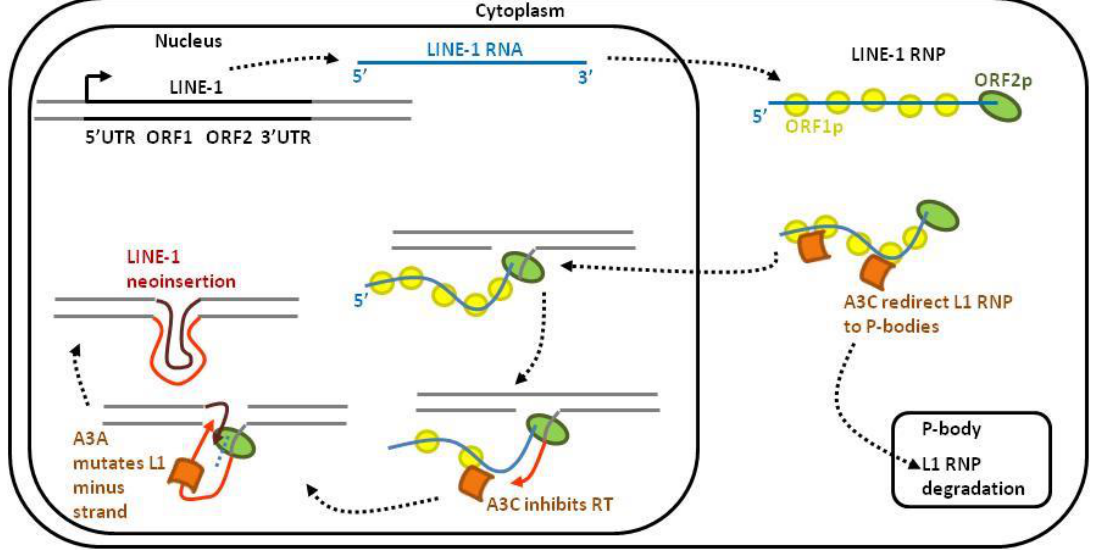
Figure 3. LINE-1 retrotransposons are targeted by APOBEC3s. After transcription, the LINE-1 mRNA is transported into the cytoplasm. After translation, the ORF1- and ORF2-encoded proteins associate with the LINE-1 RNA and form a ribonucleoprotein (RNP) complex. The LINE-1 RNP enters the nucleus, where the ORF2p endonuclease domain cleaves the chromosomal DNA. After cleavage, the 3′-hydroxyl is used by the LINE-1 reverse transcriptase to synthesize a cDNA of LINE-1. This target-site-primed reverse transcription typically results in the insertion of a 5′-truncated LINE-1 element into a new genomic location. Different APOBEC3s-dependent mechanisms control LINE-1 retrotransposition: (1) in the cytoplasm, A3C interacts with and redirects the L1-RNP into P-bodies for degradation; (2) in the nucleus, A3C inhibits reverse transcriptase processing while A3A mutates the minus strand LINE-1 DNA.